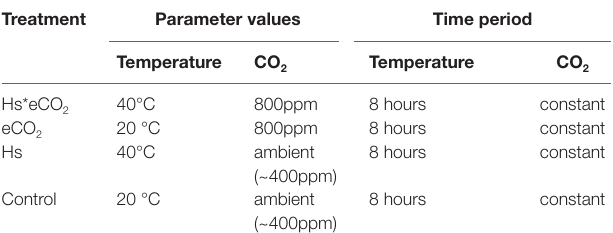
TABlE 1 | Environmental parameters and time periods for treatment application in controlled environment chamber (Control = ambient temperature (20°C) and ambient CO 2 (~400 ppm), Hs = elevated temperature (40°C), eCO 2 = elevated CO 2 (800